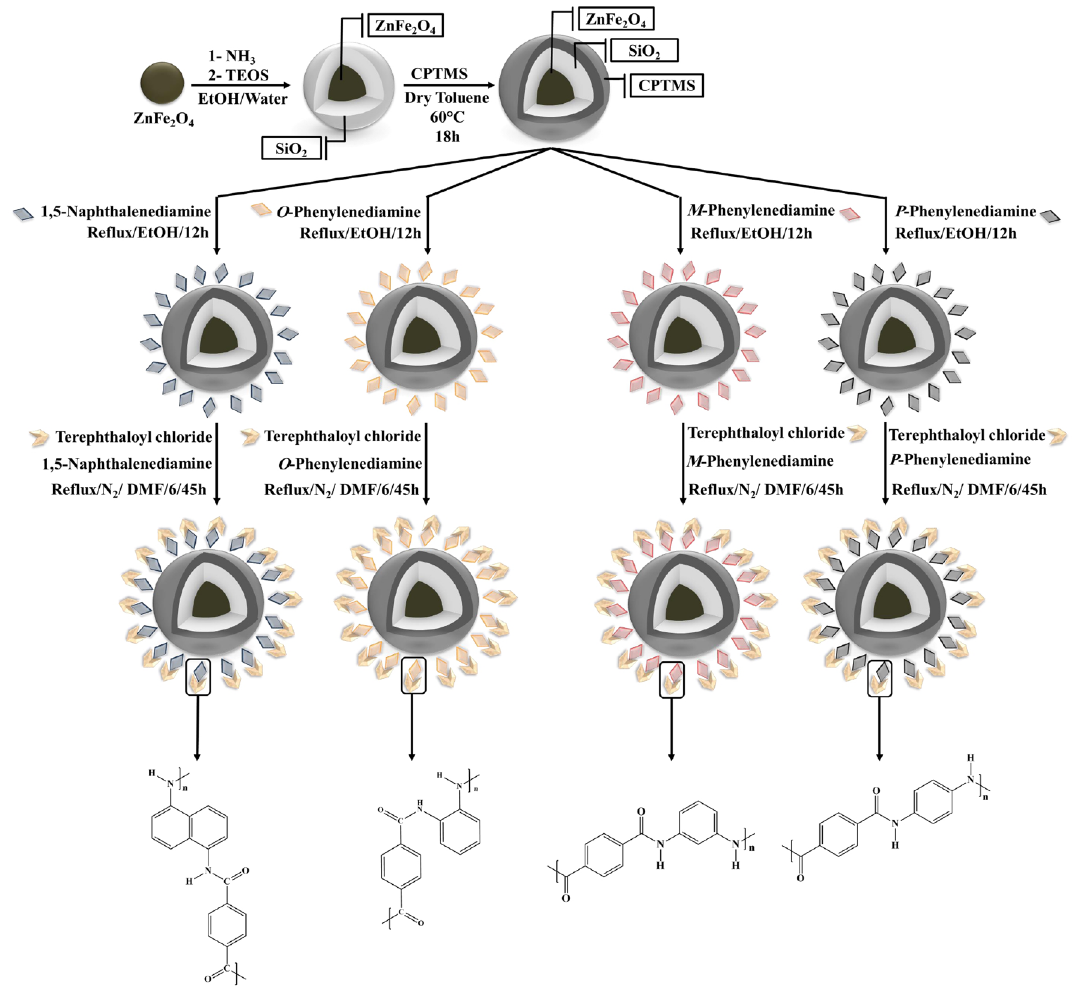
Figure 1. Graphical illustration of polymerization procedure on the surface of modified ZnFe 2 O 4